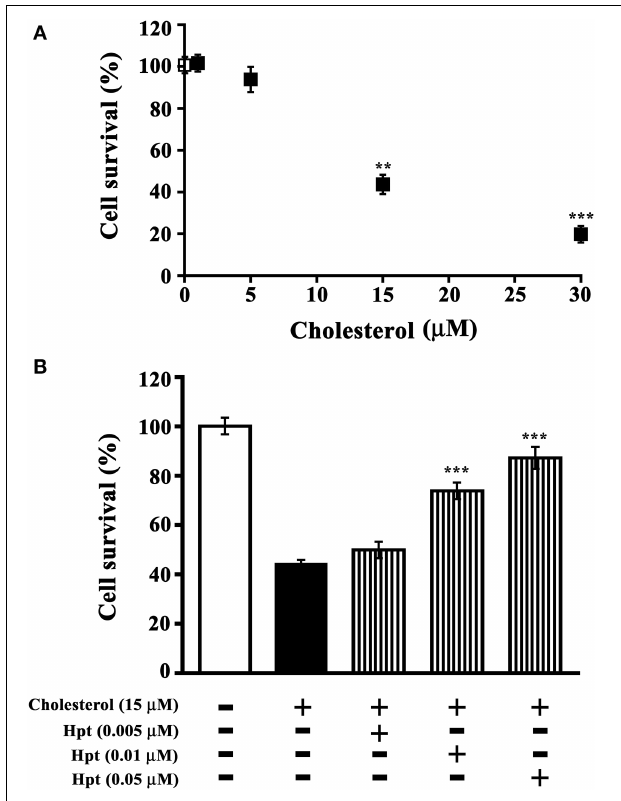
FIGURE 5 | Effect of Hpt on cholesterol-mediated neurotoxicity. (A) Differentiated SHSY5Y were incubated into 96-well plate (20h; 8 × 10 3 cells per well) in DMEM containing 0.2% BSA, 10nM ApoE, and different amounts of liposome-embedded cholesterol (0–30 μ M). Cell survival was evaluated by MTT assay, and it was expressed as percentage of viability of the control (cells cultured without cholesterol addition; open square). Significant differences from control are indicated ( ∗∗ p < 0 . 005; ∗∗∗ p < 0 . 001). Data are reported as mean ± s.e.m. (B) Differentiated SH-SY5Y were incubated into 96-well plate (20h; 8 × 10 3 cells per well) in DMEM containing 0.2% BSA, 10nM ApoE, 15 μ M liposome-embedded cholesterol, and different amounts of Hpt (0.005, 0.01, or 0.05 μ M; bars with vertical line). Cell survival was evaluated by MTT assay, and it was expressed as percentage of viability of the control (cells cultured without cholesterol and Hpt; open bar). Significant differences from cells treated by cholesterol (full bar) are indicated ( ∗∗∗ p < 0 . 001). Data are reported as mean ±